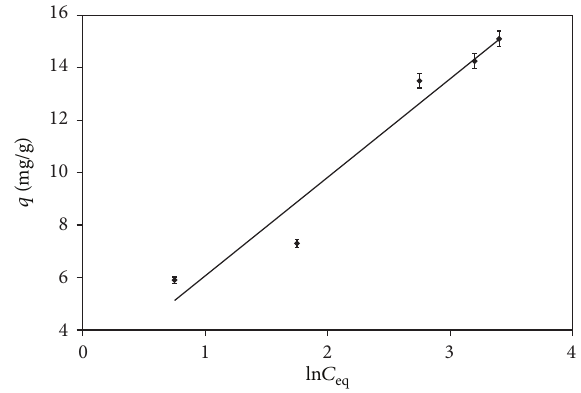
Figure 10: Pseudo-first-order biosorption of lead by Ficus beng- halensis L. for 20 mg/L of metal, 0.1g/30mL of biosorbent concen- tration, and solution pH of 6.0. Table 4. The linear regression correlation coefficient value 𝑅